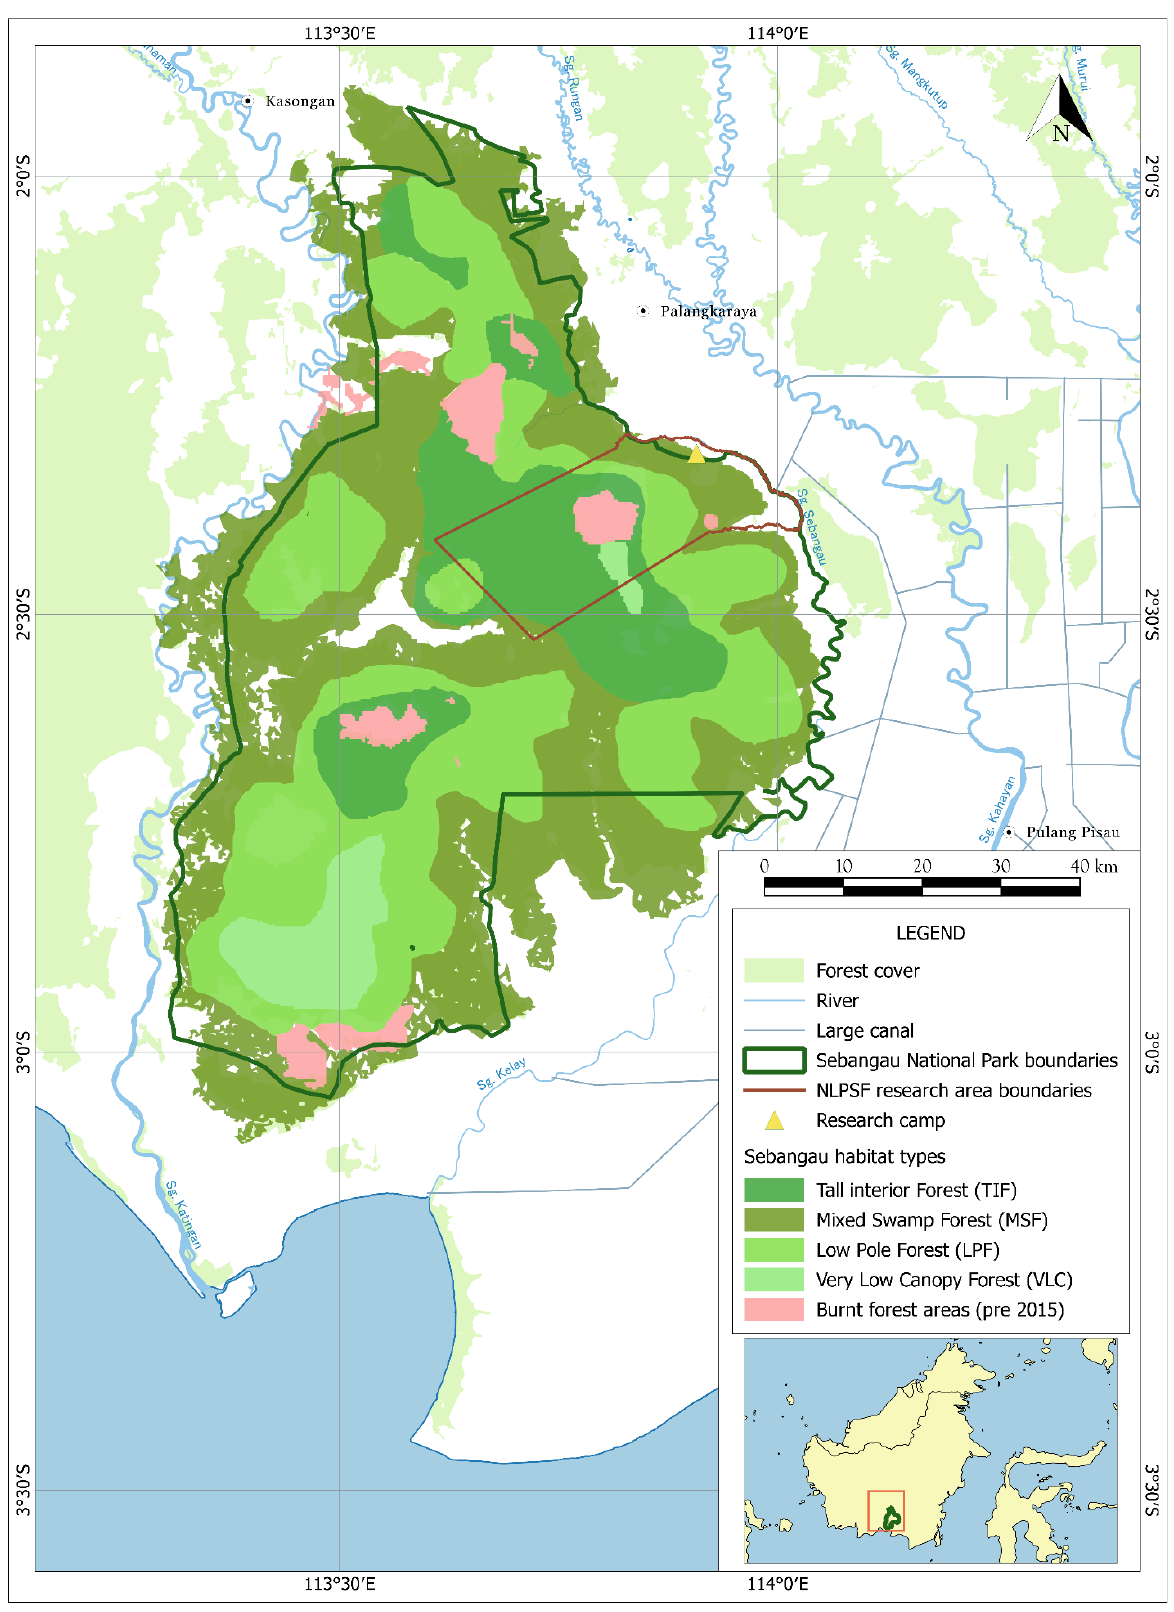
Figure 1. Map showing the location of Sebangau in Indonesian Borneo (inset), with forest cover (before the 2015 fires, when most of the species records were obtained) and distribution of habitat sub-types within the Sebangau forest. Peat swamp forest habitat outside the Sebangau forest is not differentiated into sub-types. White areas are not forested. Adapted from Ehlers Smith & Ehlers Smith